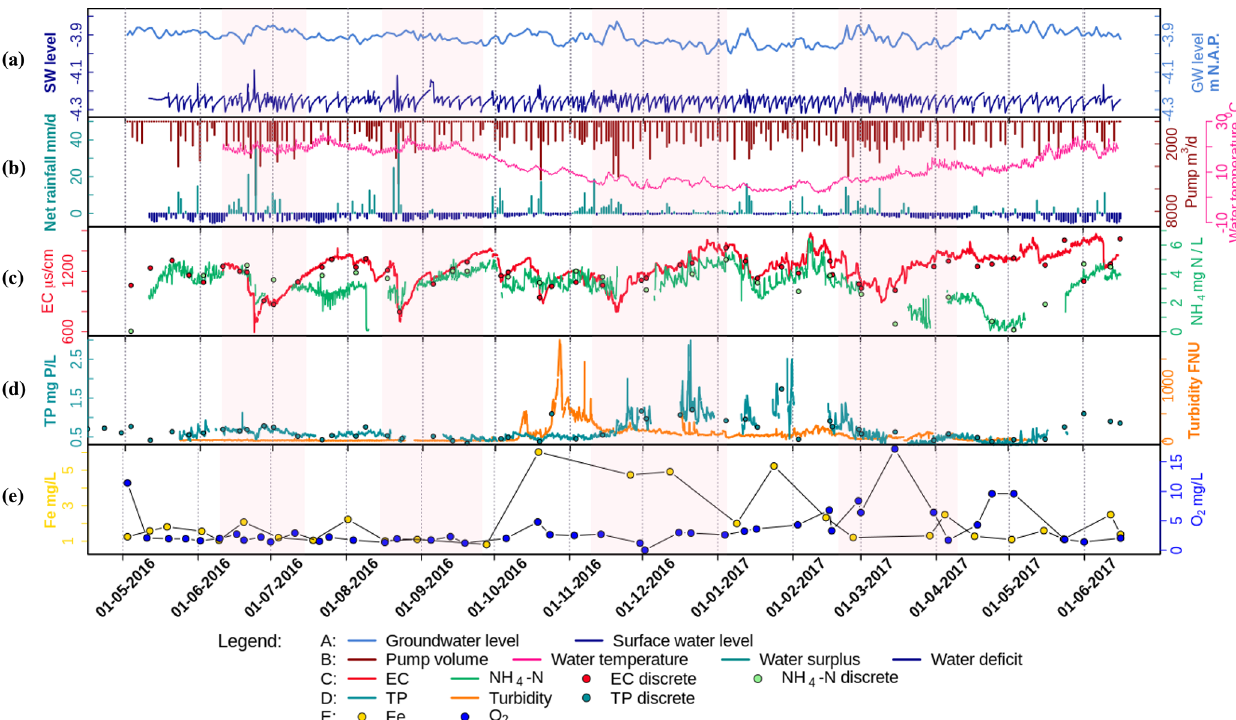
Figure 2. Time series of (a) surface water level (SW level) and groundwater level (mNAP), (b) net rainfall (daily water surplus ( + ) (light blue) and deficit ( − ) (dark blue), mmd − 1 ) and daily pumping volume (m 3 d − 1 ), (c) hourly time series of EC (µScm − 1 ) and NH 4 -N (mgNL − 1 ), (d) hourly TP and turbidity, and (e) discrete samples of Fe (total iron in water column) and O 2 concentrations (mgL − 1 ). The dots in (c) and (d) are the corresponding discrete sampling data, which are plotted to show their close match to the continuous time series data, as well as to fill in the gaps. All data were monitored at the pump station. The transparent pink blocks are the selected rain events for further analysis in Sect. 3.3. See Tables S1–S3 for the correlation tests performed on the